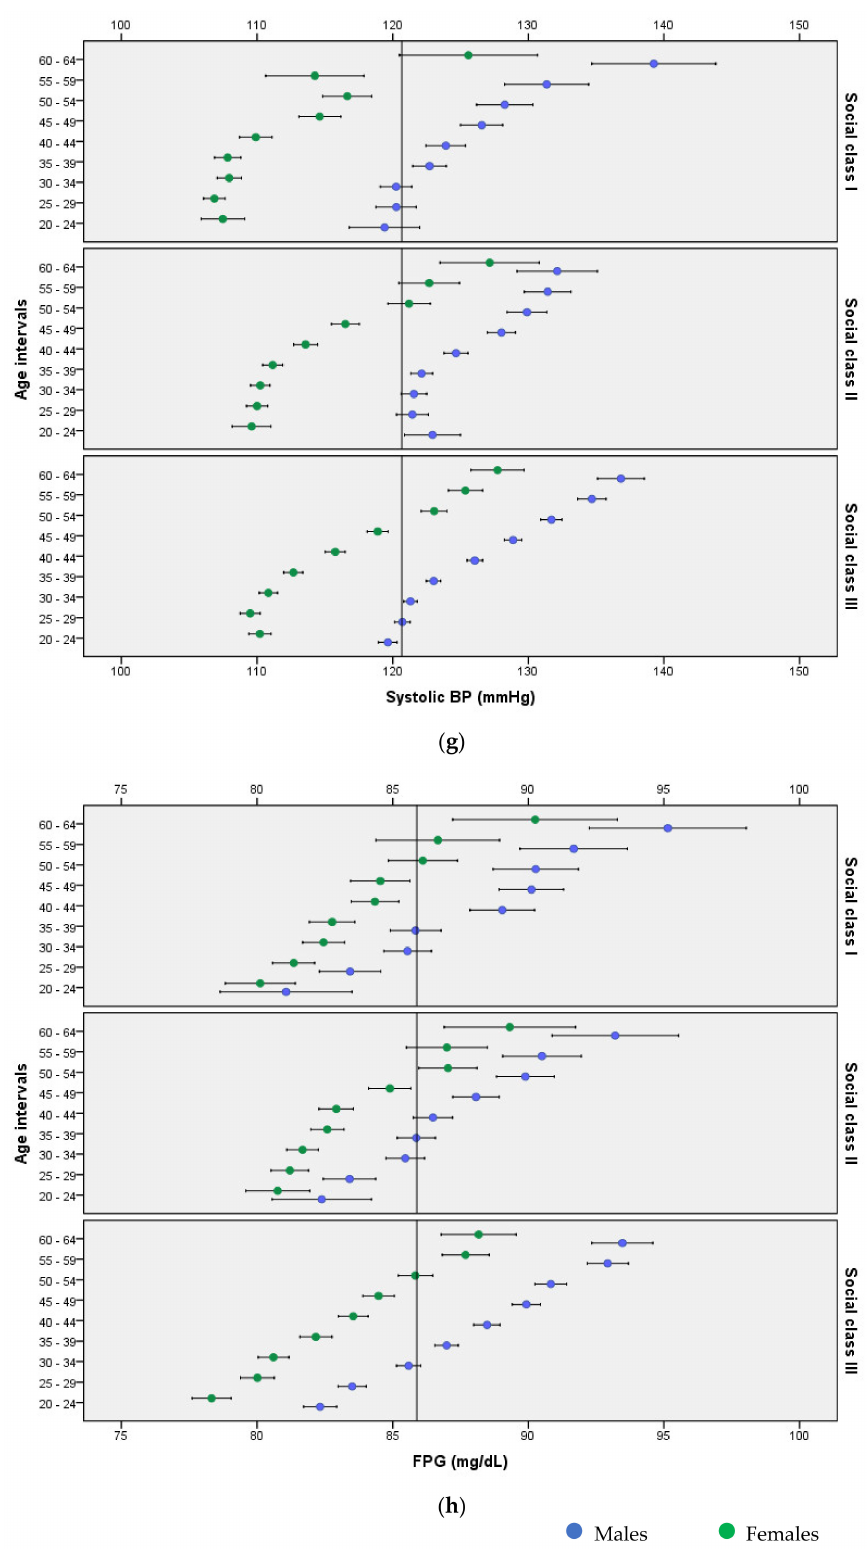
Figure 1. Distribution of mean and 95% CI of BMI, systolic and diastolic BP, T-Chol, HDL-C, TG, glucose, and WC by age and social class in men and women for different age groups. Panel description: ( a ) BMI: body mass index; ( b ) WC: waist circumference; ( c ) T-Chol: total cholesterol; ( d ) HDL-C: high density lipoprotein cholesterol; ( e ) TG: triglycerides; ( f ) Diastolic BP: diastolic blood pressure; ( g ) Systolic BP: systolic blood pressure; ( h ) FPG: fasting plasma